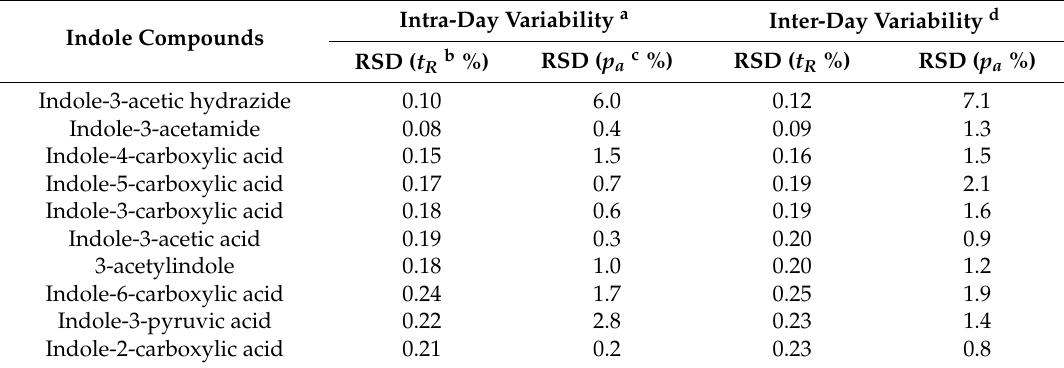
Table 3. Precision of 10 indole compounds for retention time ( t R ) and peak area ( p a ) expressed as RSDs (%).